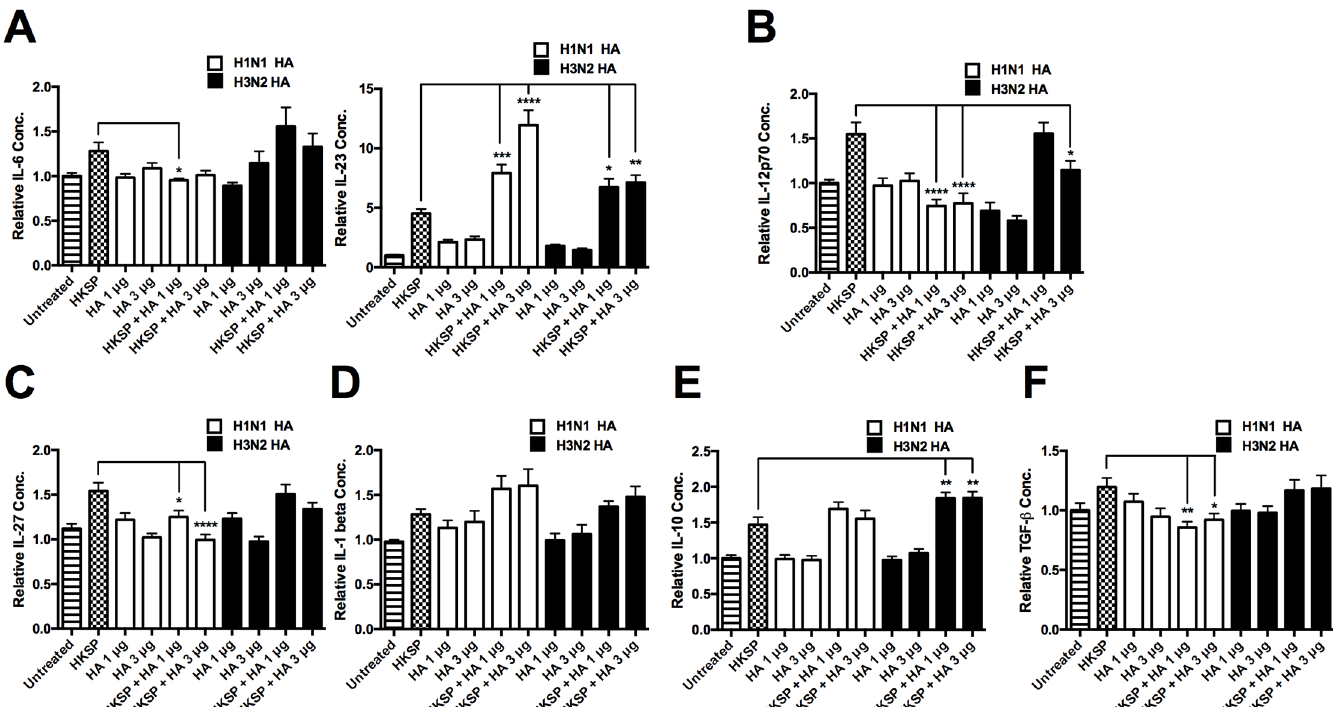
Fig 5. Influenza HA specifically attenuates innate cytokines in HKSP-treated cells. The levels of (A) IL-6, IL-23, (B) IL-12p70, (C) IL-27, (D) IL-1 β , (E) IL-10 and (F) TGF- β secreted by CD14 + cells following 24 h treatment with HKSP, H1N1 HA (1 μ g ml -1 or 3 μ g ml -1 ) or H3N2 HA (1 μ g ml -1 or 3 μ g ml -1 ) alone or in combination with HKSP (or untreated as a control) were established by ELISA. Each column represents normalised mean cytokine levels + SEM of at least 3 experimental repeats of each treatment/donor. Each ELISA represents normalised results from multiple donors: (A) IL-6 (n = 3), IL-23 (n = 4), (B) IL-12p70 (n = 3), (C) IL-27 (n = 6), (D) IL-1 β (n = 4), (E) IL-10 (n = 4), and, TGF- β (n = 3). Statistical analyses were performed to compare cytokine levels in cells exposed to HKSP versus cells exposed to H1N1 HA or H3N2 HA (1 μ g ml -1 or 3 μ g ml -1 ) in combination with heat-inactivated HKSP, by fitting a One-way ANOVA to the data and using a Sidak test to adjust for multiple testing ( (cid:3) p < 0.05, (cid:3)(cid:3) p < 0.01, (cid:3)(cid:3)(cid:3) p < 0.001, (cid:3)(cid:3)(cid:3)(cid:3) p <